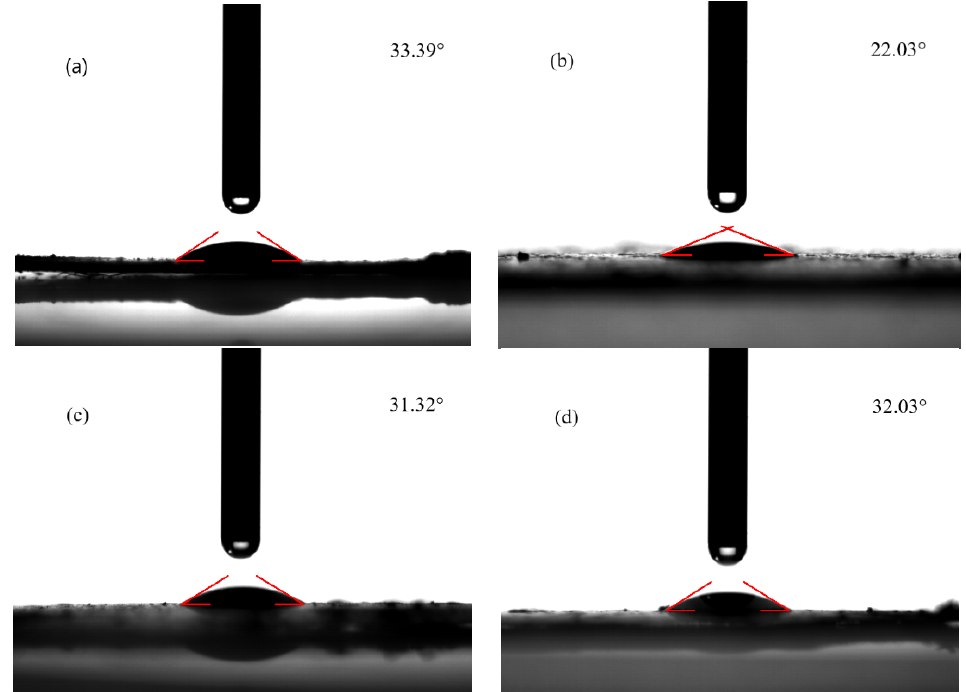
Figure 4. Contact angles of ( a ) S1, ( b ) S2, ( c ) S3 and ( d ) S4. ( a ) was reproduced from Ref. [8] with permission from Elsevier.